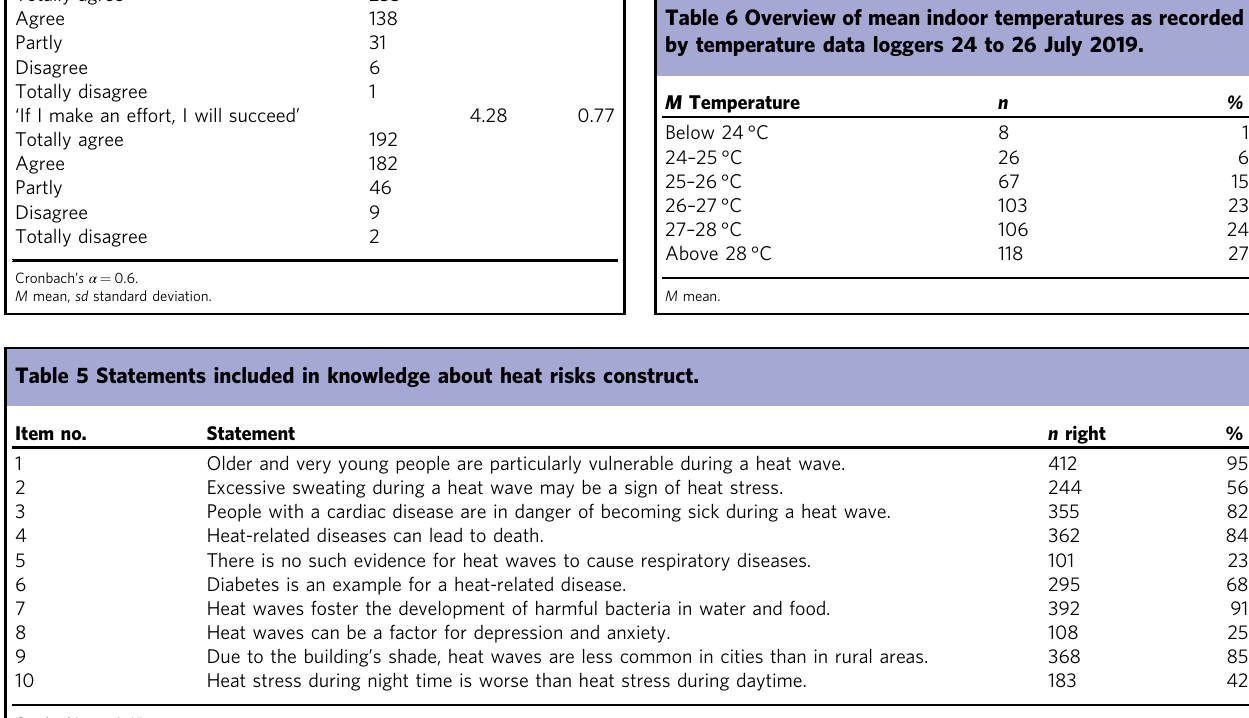
Table 6 Overview of mean indoor temperatures as